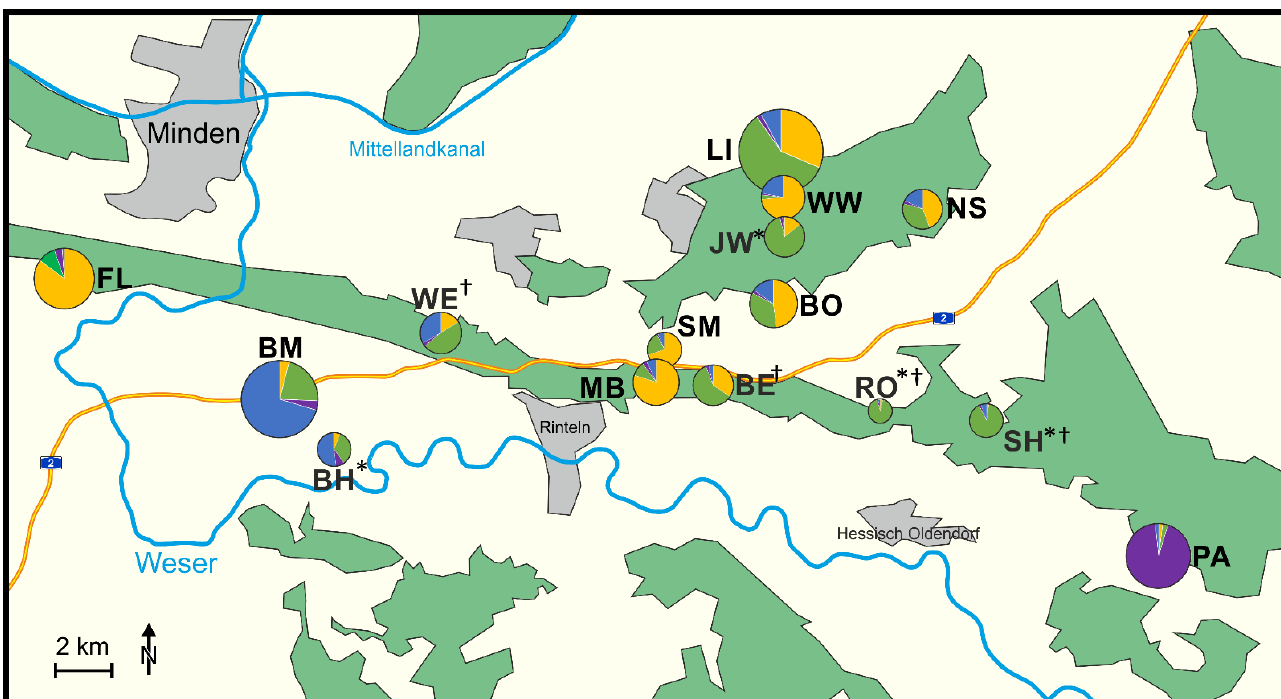
Figure 1. Study area, locations of the 15 sample sites in the northern Weser Hills and geographic distribution of the four estimated genetic clusters (see Results and Figure 2). Coloration indicates the membership of the individuals to the given cluster. Pie chart size is relative to the number of sampled individuals per study site. Fuchsloch (“FL”), Edler/Brinkmeyer (“BM”), Bokshorn (“BH”), Wülpker Egge (“WE”), Messingsberg (“MB”), Schlingmühle (“SM”), Bernsen (“BE”), Liekwegen (“LI”), Waldwiese (“WW), JBF-Wiese (“JW”), Borstel (“BO”), Rohden (“RO”), Nato-Station (“NS”), Segelhorst (“SH”), and Pötzen (“PA”). * = n < 10. † = reintroduced populations, n total individuals = 440.